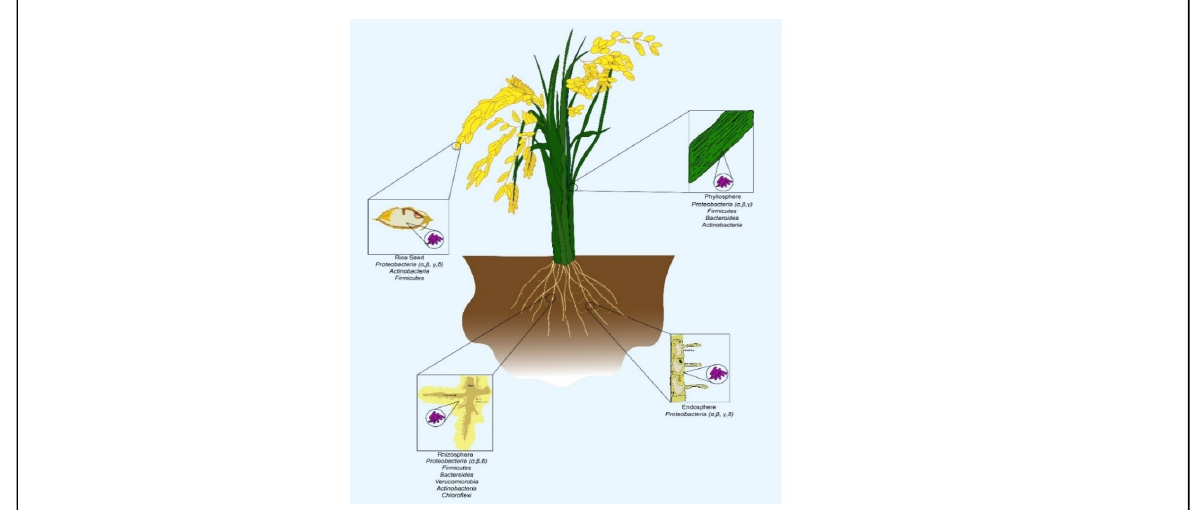
Figure 1: Bacterial diversity in rice: Bacterial community living in the rice plant can be grouped into three types: rhizosphere, endosphere and phyllosphere, dominance phyla in these three regions of rice